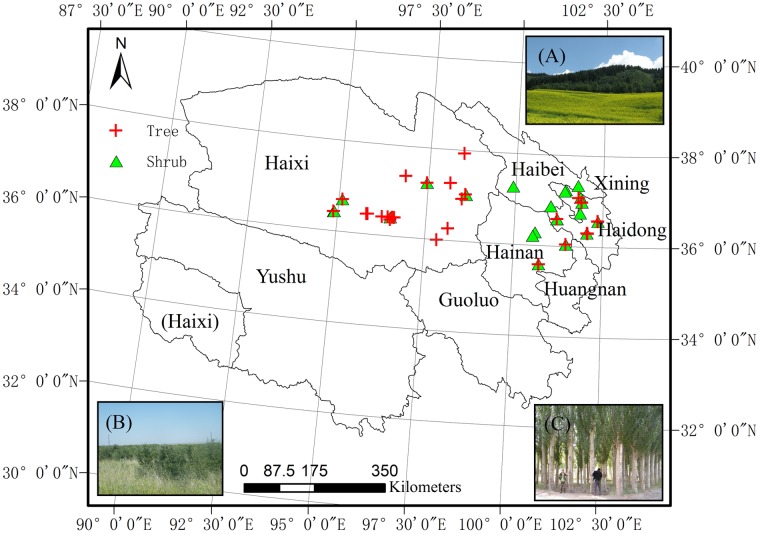
Location of the 48 sample sites in Qinghai province. The three plates in the corners of the map show the typical forest types.(A) A 21-year-old planted forest (Larch) under rain-fed conditions in the eastern hilly region, (B) a 9-year-old planted shrubland (Hippophae rhamnoides) in the middle region, and (C) a 31-year-old planted forest (Populus bolleana) with irrigation in the west region.